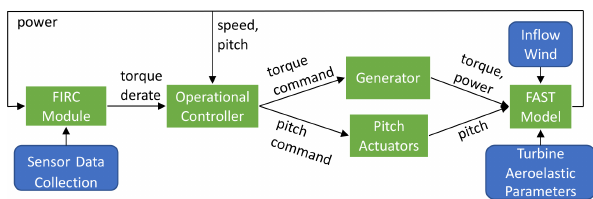
Figure 3. Simplified CART3 model block